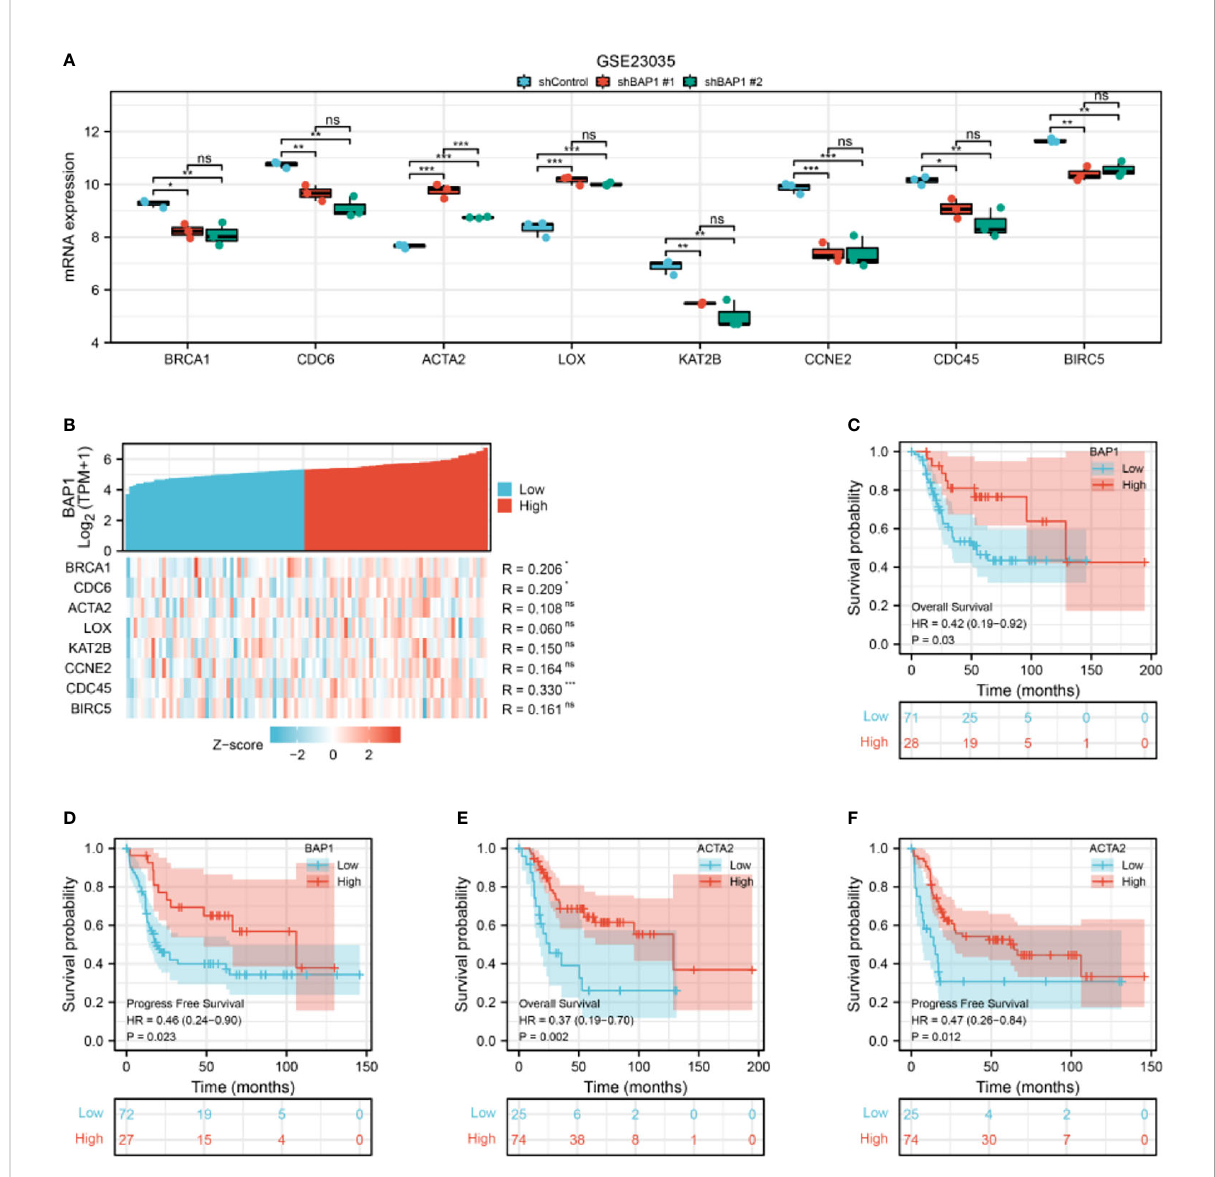
FIGURE 7 The expression and prognostic value of hub genes in GSE23035 and osteosarcoma dataset of TARGET database. (A) Hub genes expression in GSE23035. (B) The correlation of BAP1 and hub genes in the osteosarcoma dataset of TARGET database. (C) The overall survival of osteosarcoma patients in low and high BAP1 groups in TARGET database. (D) The progress free survival of osteosarcoma patients in low and high BAP1 groups in TARGET database. (E) The overall survival of osteosarcoma patients in low and high ACTA2 groups in TARGET database. F, The progress free survival of osteosarcoma patients in low and high ACTA2 groups in TARGET database. *p < 0.05; **p < 0.01; ***p < 0.01. ns, non signi fi